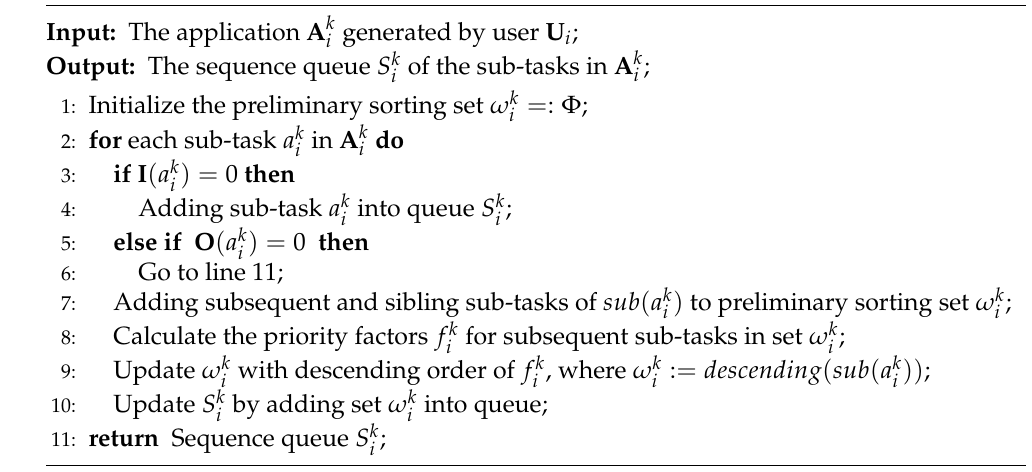
Algorithm 2 Preliminary Sorting Mechanism